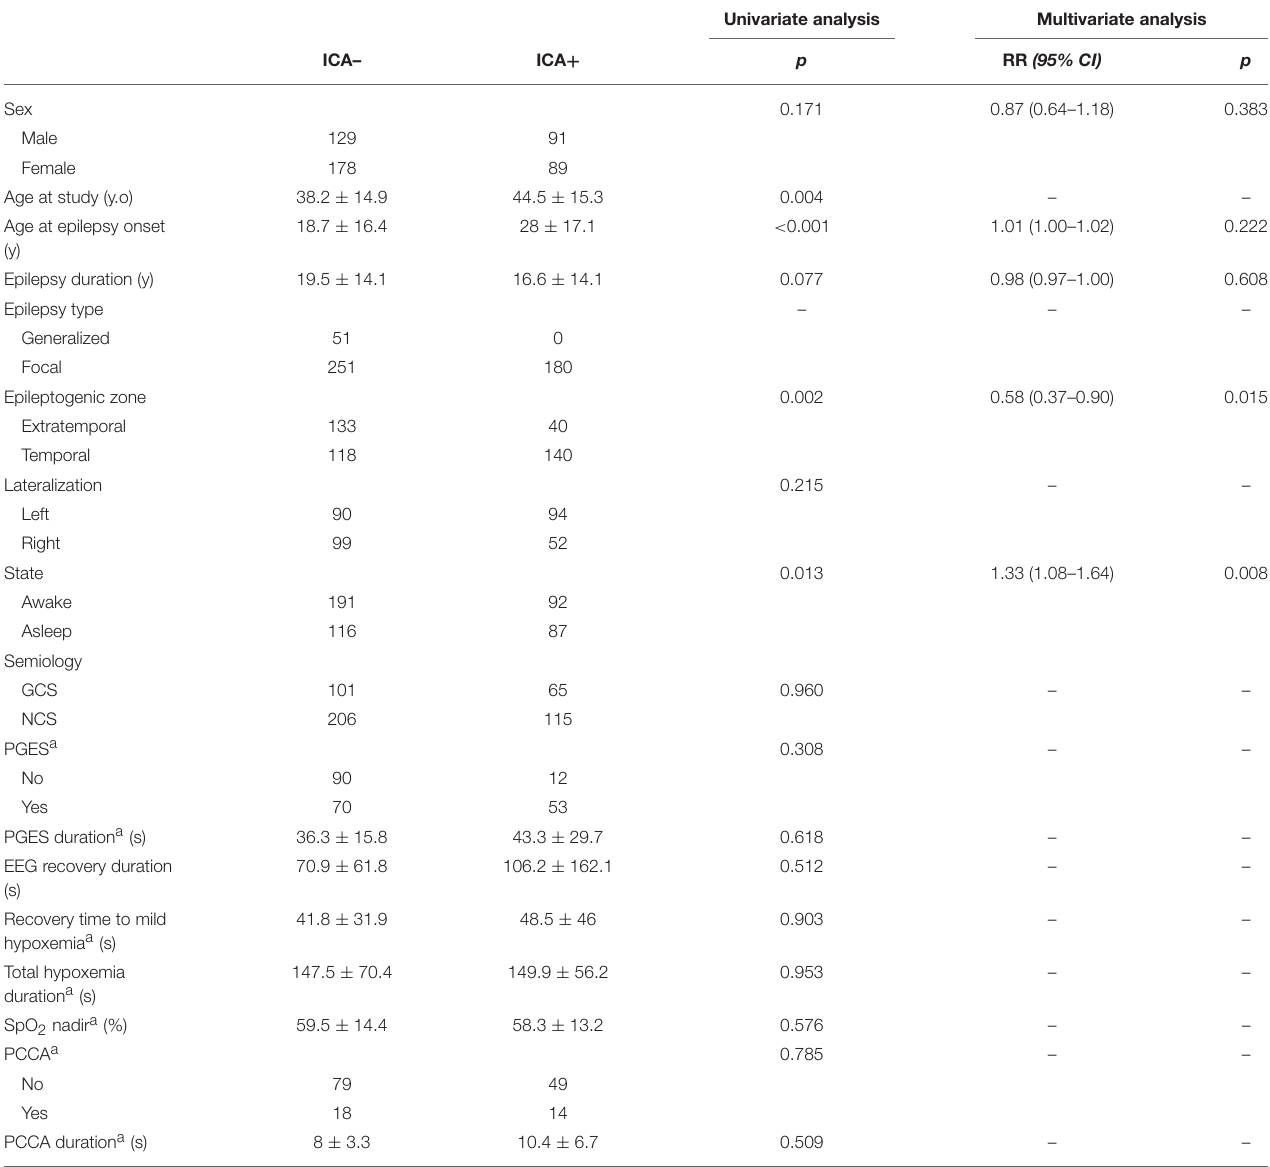
TABLE 2 | ICA incidence and seizure